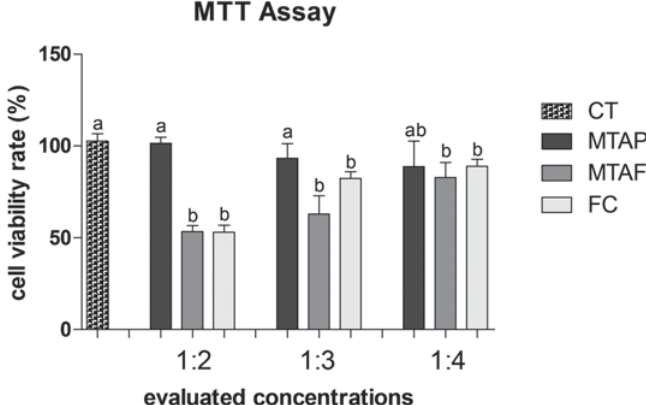
Figure 2- Cell viability rate (%) according to MTT assay in human dental pulp cells (hDPCs) exposed to MTA Plus (MTAP), MTA Fillapex (MTAF), FillCanal (FC) and culture medium used as control (CT). Bars with different letters represent